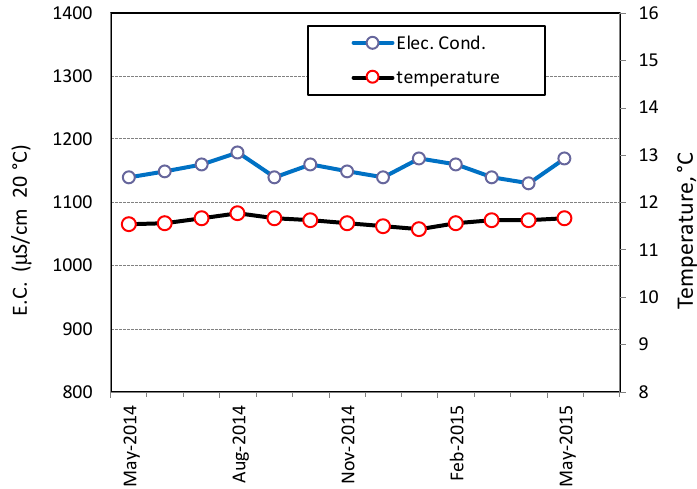
Figure 7. Temperature and electrical conductivity measured in the Grassano river, just below spring outlets; monthly measurements from May 2014 to May 2015 (modified from Fiorillo et al. [33]).